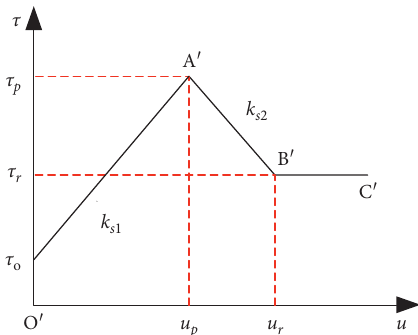
Figure 8: Relationship between the interface shear stress and the displacement of the trilinear ( τ − u